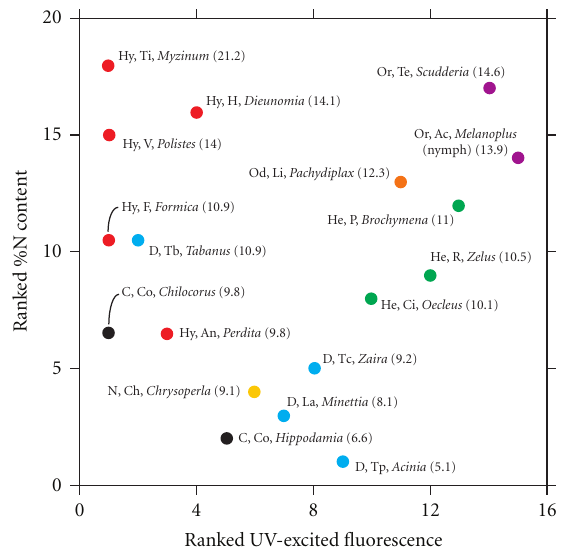
Figure 6: Adult insects ranked and plotted by genera in relation to mean %N of body dry-mass (in parentheses, from [16, Table 1]) and area of UV-excited fluorescence relative to body